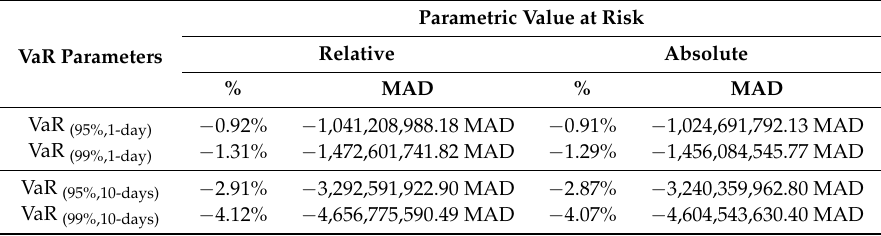
Table produced on Excel under VBA by the